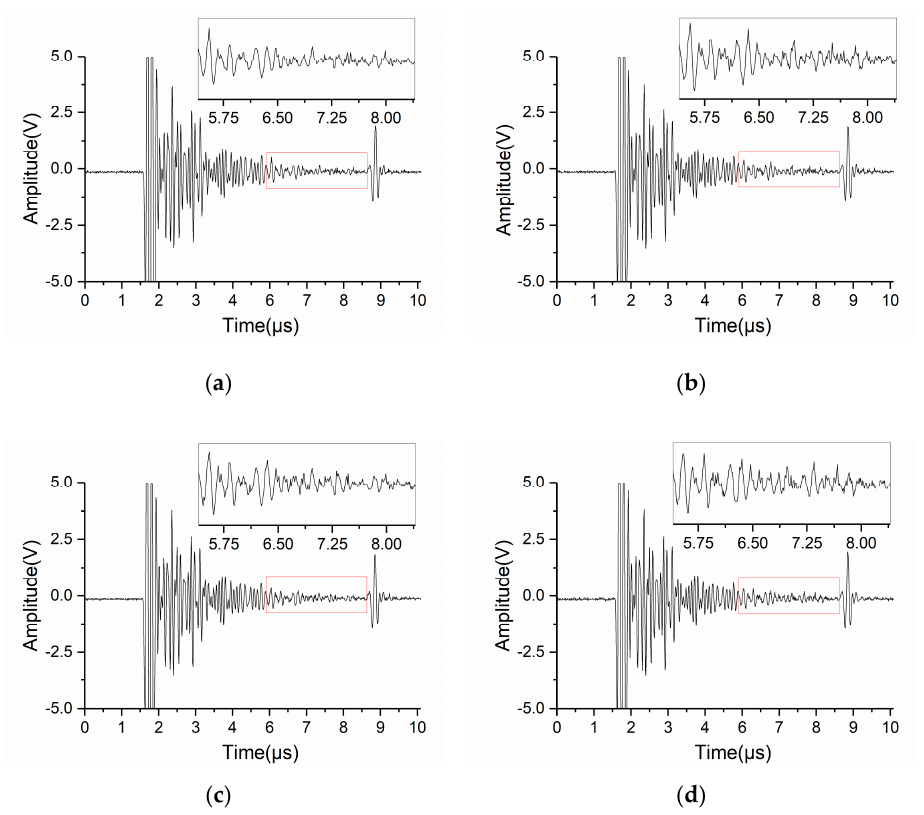
Figure 6. Ultrasonic signals randomly selected in results of experiment set Defect-free-1. ( a ) signal 1 ( b ) signal 2 ( c ) signal 3 ( d ) signal